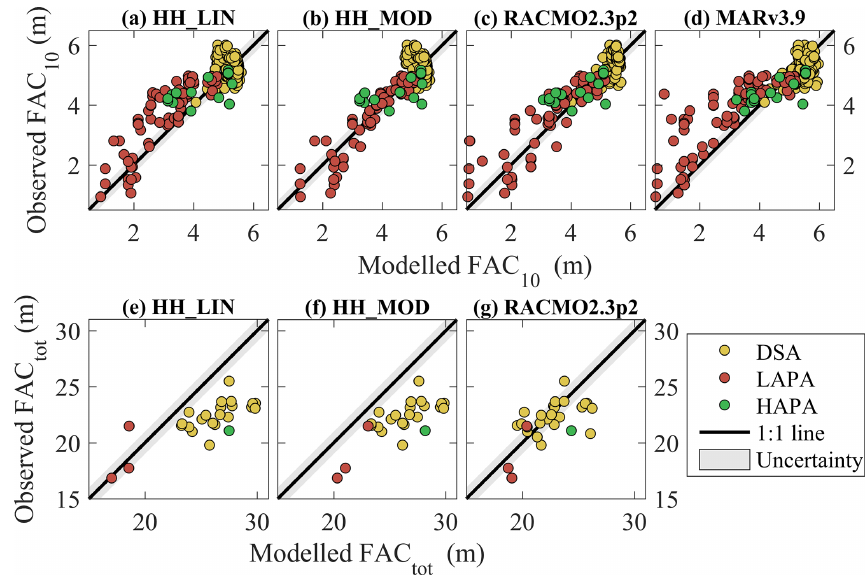
Figure 6. Comparison between the observed FAC 10 and FAC tot and the simulated FAC in the corresponding cells of three RCMs. Table 4. Performance of the RCMs for FAC 10 and FAC tot in terms of bias (average difference between model and observations) and root- mean-squared difference